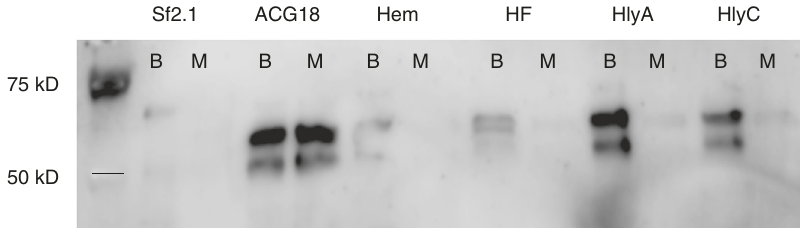
Fig. 4 Scorpine is conditionally expressed in all BMI isolates when blood is present. Expression of scorpine was evaluated from colonies collected from minimal media agar plates (M) and chocolate agar plates that contain lysed blood (B) in a western analysis using an anti-alkaline phosphatase antibody to detect the fusion constructs. Two bands were detected by the antibody. The larger band (ca. 61.1 kD) correlates with the size of the secreted protein that contains the secretion signal while the smaller band (ca. 55.4 kD) correlates to the size of the protein construct lacking the secretion signal. All conditional constructs show protein production only when blood is supplemented in the media, whereas the constitutive strain (ACG18) produces the fusion protein on both media. SF2.1 = wild type Asaia ; ACG18 = constitutive expression of scorpine by Asaia ; all others are strains where scorpine is driven by a